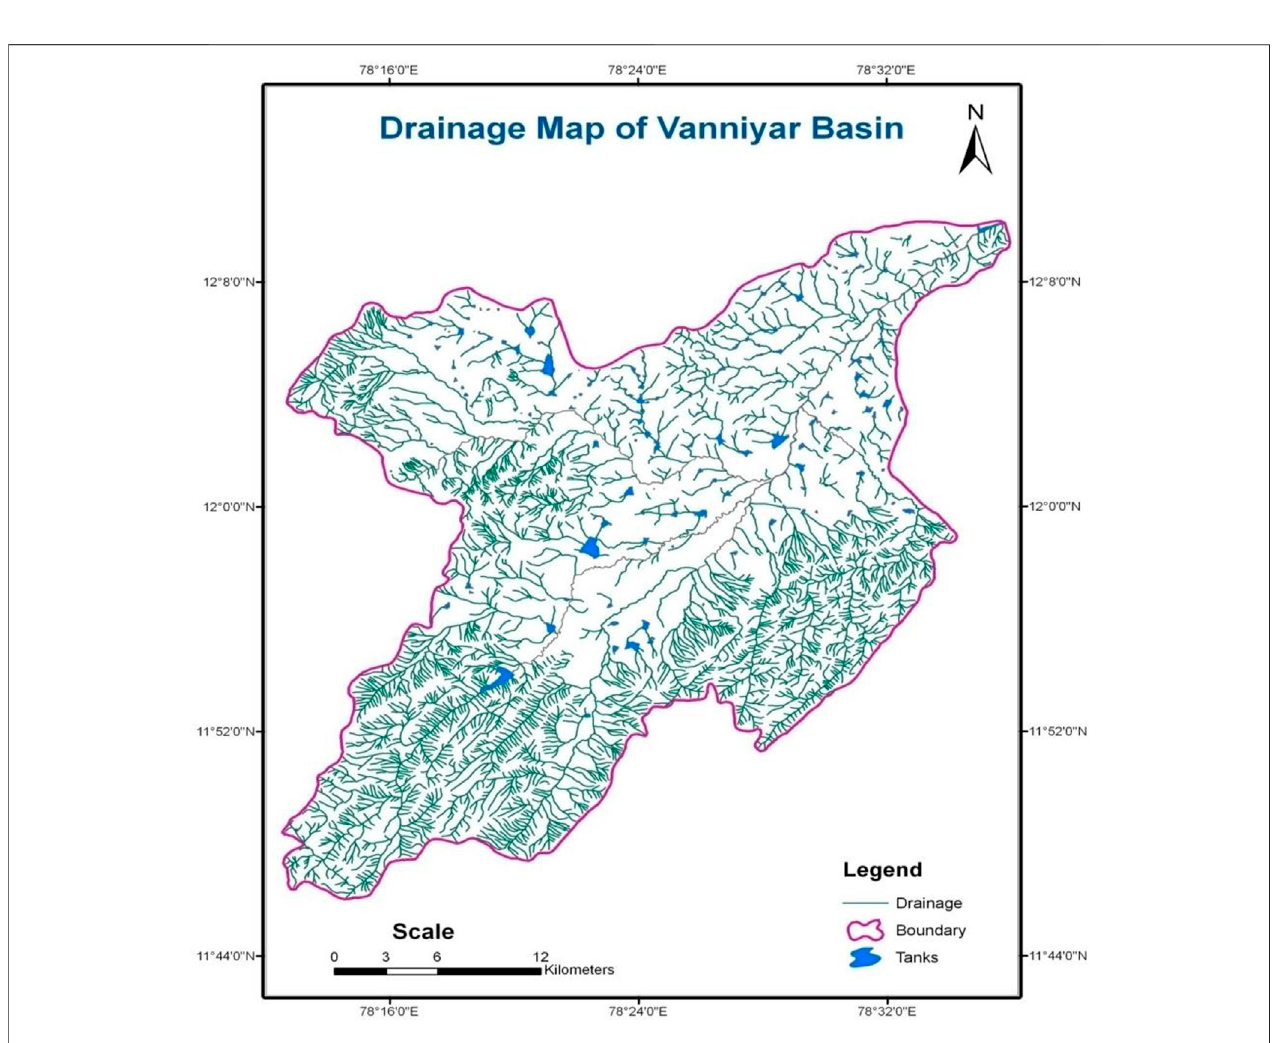
FIGURE 6 | Drainage of the Vanniyar basin, Dharmapuri district, Tamil Nadu, India.